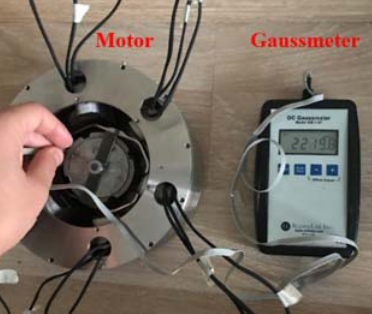
Figure 16. The gaussmeter device and the motor for the measurements of magnetic flux density.